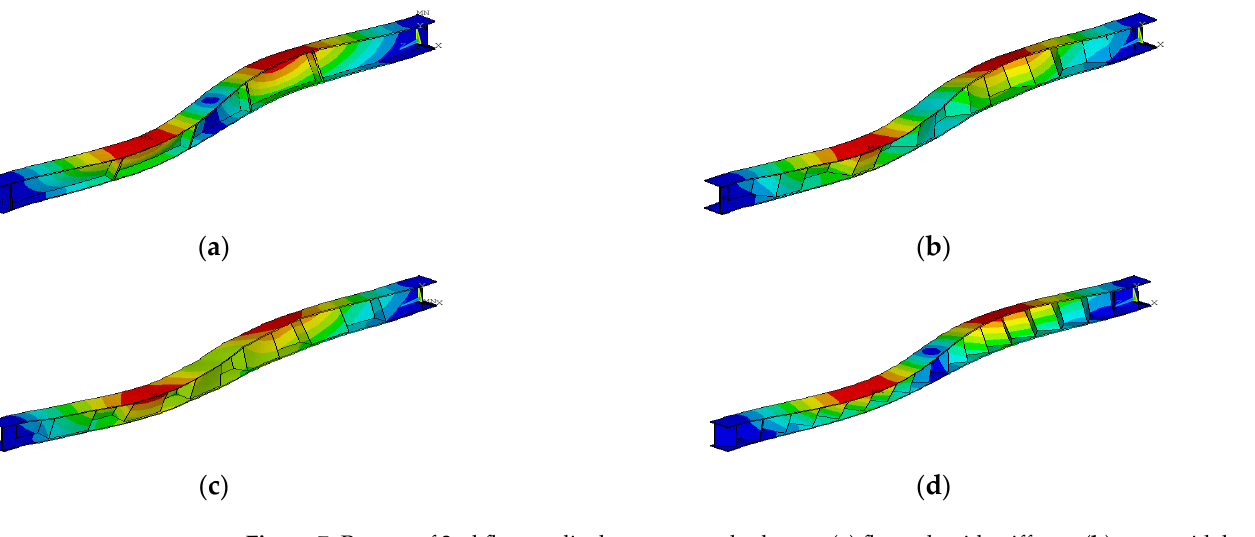
Figure 6. Pattern of 1st flexure displacement mode shapes: ( a ) flat web with stiffener, ( b ) trapezoidal web, ( c ) rectangular web, and ( d ) triangular web.